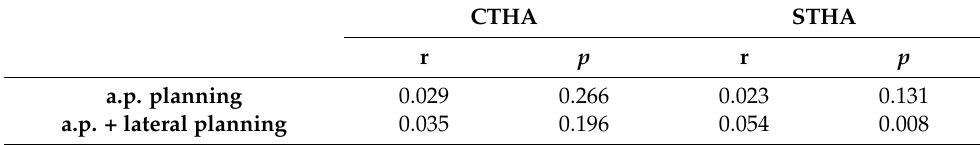
Table 5. Kendall’s coefficient of concordance as a value for the consistency between the raters.